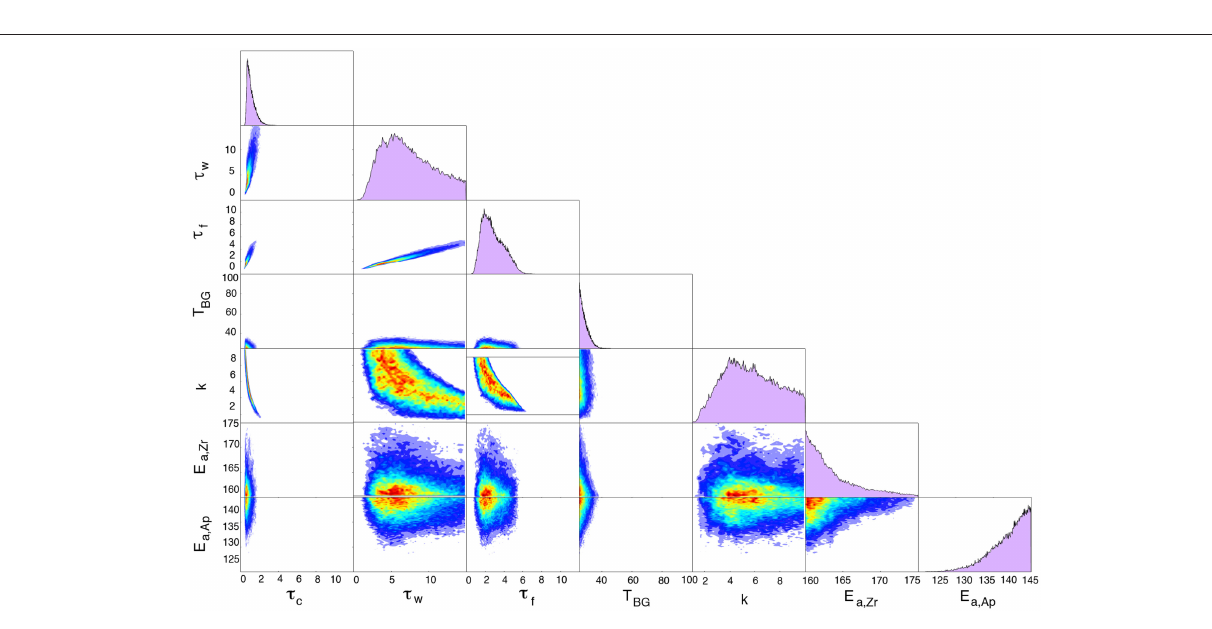
FIGURE 10 | MCMC marginal posterior PDFs as in Figure 8 and bivariate covariance plots for the Lee dike. Warmer colors in covariance plots indicate higher probability. T BG , τ c , τ w , k , E a , Ap , E a , Zr are estimated parameters, while total flow duration τ f is derived using Equation